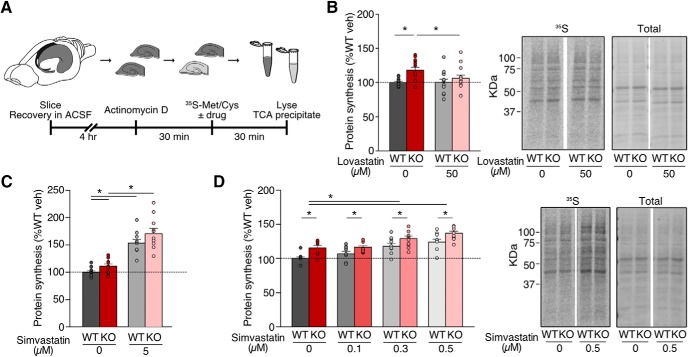

Simvastatin exaggerates excessive protein synthesis in the Fmr1-/y hippocampus. Slices were prepared from WT and Fmr1-/y hippocampi and incubated in vehicle, lovastatin, or simvastatin at different concentrations. A, Schematic shows time course for metabolic labeling experiments of hippocampal slices. B, Lovastatin significantly decreases protein synthesis in Fmr1-/y slices to WT levels (ANOVA genotype *p = 0.0106; Sidak’s WT veh vs KO veh *p = 0.0032, KO veh vs KO lova *p = 0.0368; n = 12). C, Simvastatin raises protein synthesis in both WT and Fmr1-/y slices at 5 μM (ANOVA treatment *p < 0.0001, genotype *p = 0.0294; Sidak’s WT veh vs 5 μM *p = 0.0001, KO veh vs 5 μM *p < 0.0001; n = 10). D, Simvastatin raises protein synthesis at 0.1–0.5 μM, exaggerating the excessive protein synthesis phenotype (ANOVA treatment *p < 0.0001, genotype *p = 0.0068; Sidak’s WT veh vs 0.3 μM *p = 0.0002, WT veh vs 0.5 μM *p < 0.0001, KO veh vs 0.3 μM *p = 0.0035, KO veh vs 0.5 μM *p < 0.0001, WT veh vs KO veh *p = 0.0005, WT 0.1 μM vs KO 0.1 μM *p = 0.0406, WT 0.3 μM vs KO 0.3 μM *p = 0.0115, WT 0.5 μM vs KO 0.5 μM *p = 0.0038; n = 9). Representative samples were run on SDS-PAGE gels and transferred to membranes. Example phosphorimages of 35S-labeled proteins and total protein staining of the same membrane are shown. Error bars = SEM. N = littermate pairs. Figure Contributions: Melania Muscas and Susana R. Louros performed the experiments and analyzed the data.